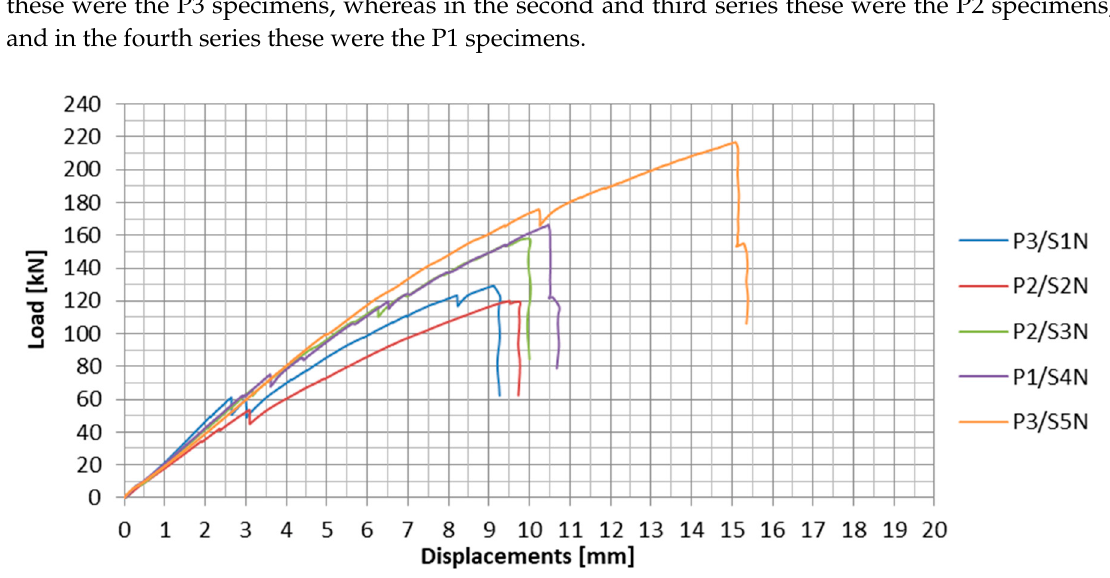
Figure 22. Failure mode of the subsequent specimens in the S5N series: ( a ) P1/S5N, ( b ) P2/S5N, ( c ) P3/S5N.